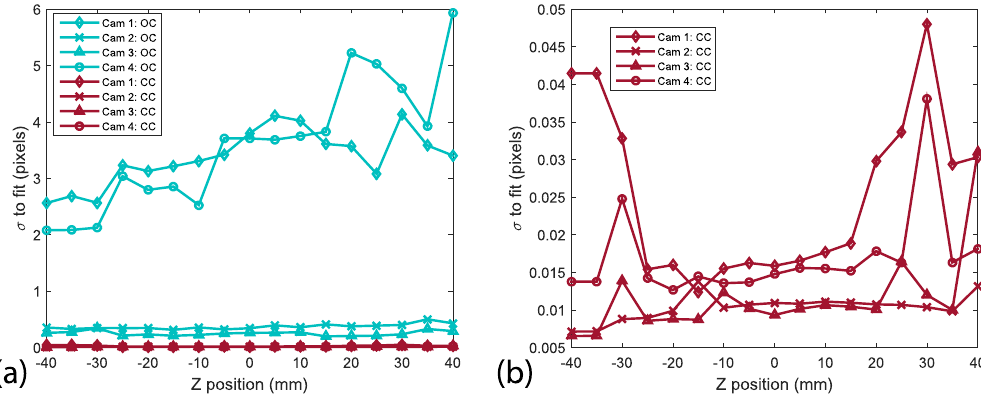
Figure 12. ( a ) Standard deviation of the original calibration fit (OC, cyan color), and corrected calibration (CC, red color) after three iterations of the self-calibration algorithm as a function of depth position z. ( b ) Detailed plot of the corrected